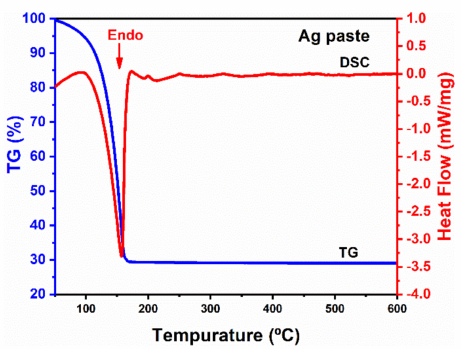
Figure 5. TG–DSC results of the Ag agglomerates paste heated in N 2